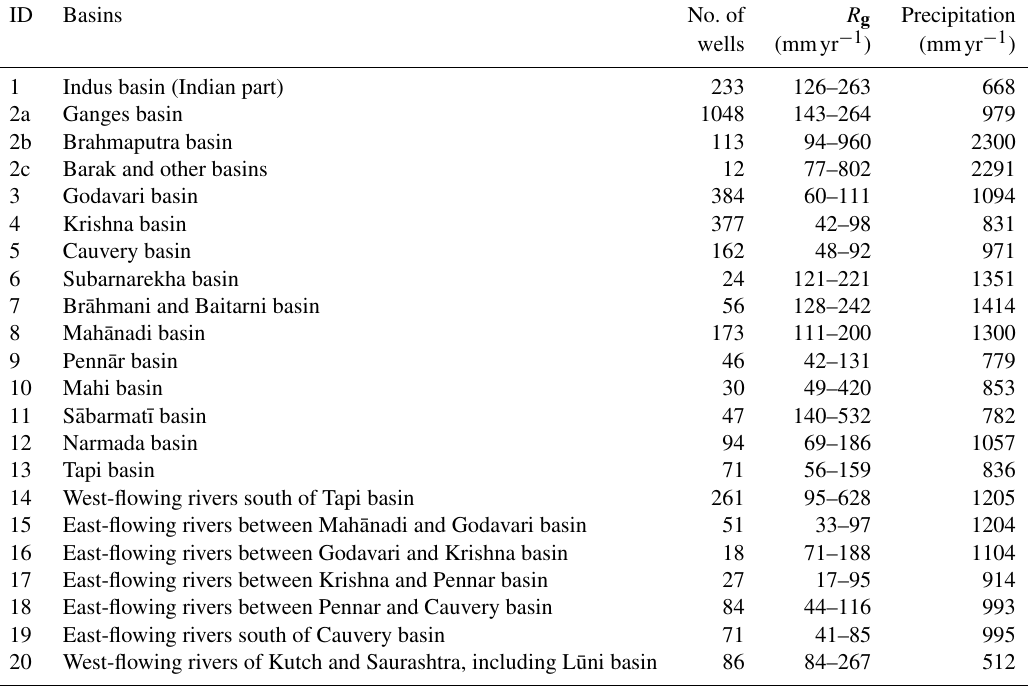
Table 1. Basin-wide annual mean recharge rates (mmyr − 1 ), and average precipitation rates in